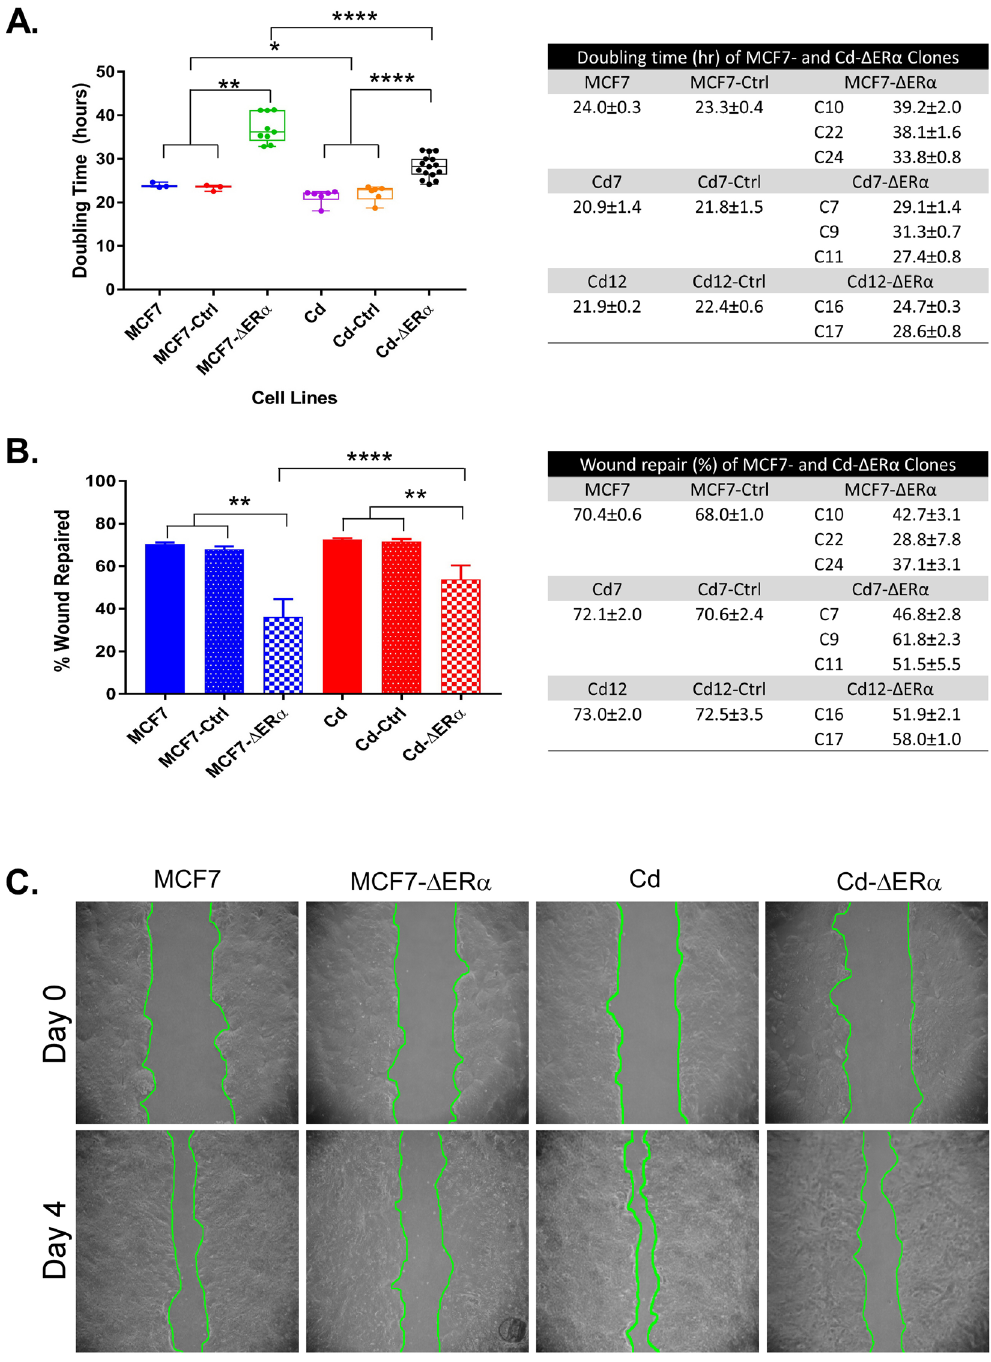
Figure 1. Characterization of MCF7, Cd7, and Cd12 cells after ER α knockout. ( A ) Approximately 5 × 10 4 cells were seeded in 6-well plates, and the total cell number was determined after 24, 72, 96, and 120 hours to calculate the population doubling time of each cell line. MCF7- Δ ER α included MCF7-C10, MCF7-C22, and MCF7-C24 clones, and Cd- Δ ER α included Cd7-C7, Cd7-C9, Cd7-C11, Cd12-C16, and Cd12-C17. The data were derived from the means of three independent experiments (with standard error of mean (SEM); n = 3, 3, 9, 6, 6, 15, left to right) and analyzed using the Wilcoxon-Mann-Whitney test to determine statistical significance ( * p < 0.05; ** p < 0.01; **** p < 0.0001). Table shows the average doubling times of each cell line ( n = 3 for all). ( B ) Migration ability for each control and clone was quantified by comparing the surface area of the scratch wounds at day 0 and day 4. The data represent the means of three independent experiments of triplicate samples with SEM ( n = 3, 3, 9, 6, 6, 15, left to right). Data analysis was performed using the Wilcoxon-Mann-Whitney test ( ** p < 0.01; **** p < 0.0001). Table shows the average migration ability of each cell line ( n = 3 for all). ( C ) Representative images of MCF7, MCF7- Δ ER α , Cd (MCF7-Cd), and Cd- Δ ER α cells at days 0 and 4 with the wound outlined in